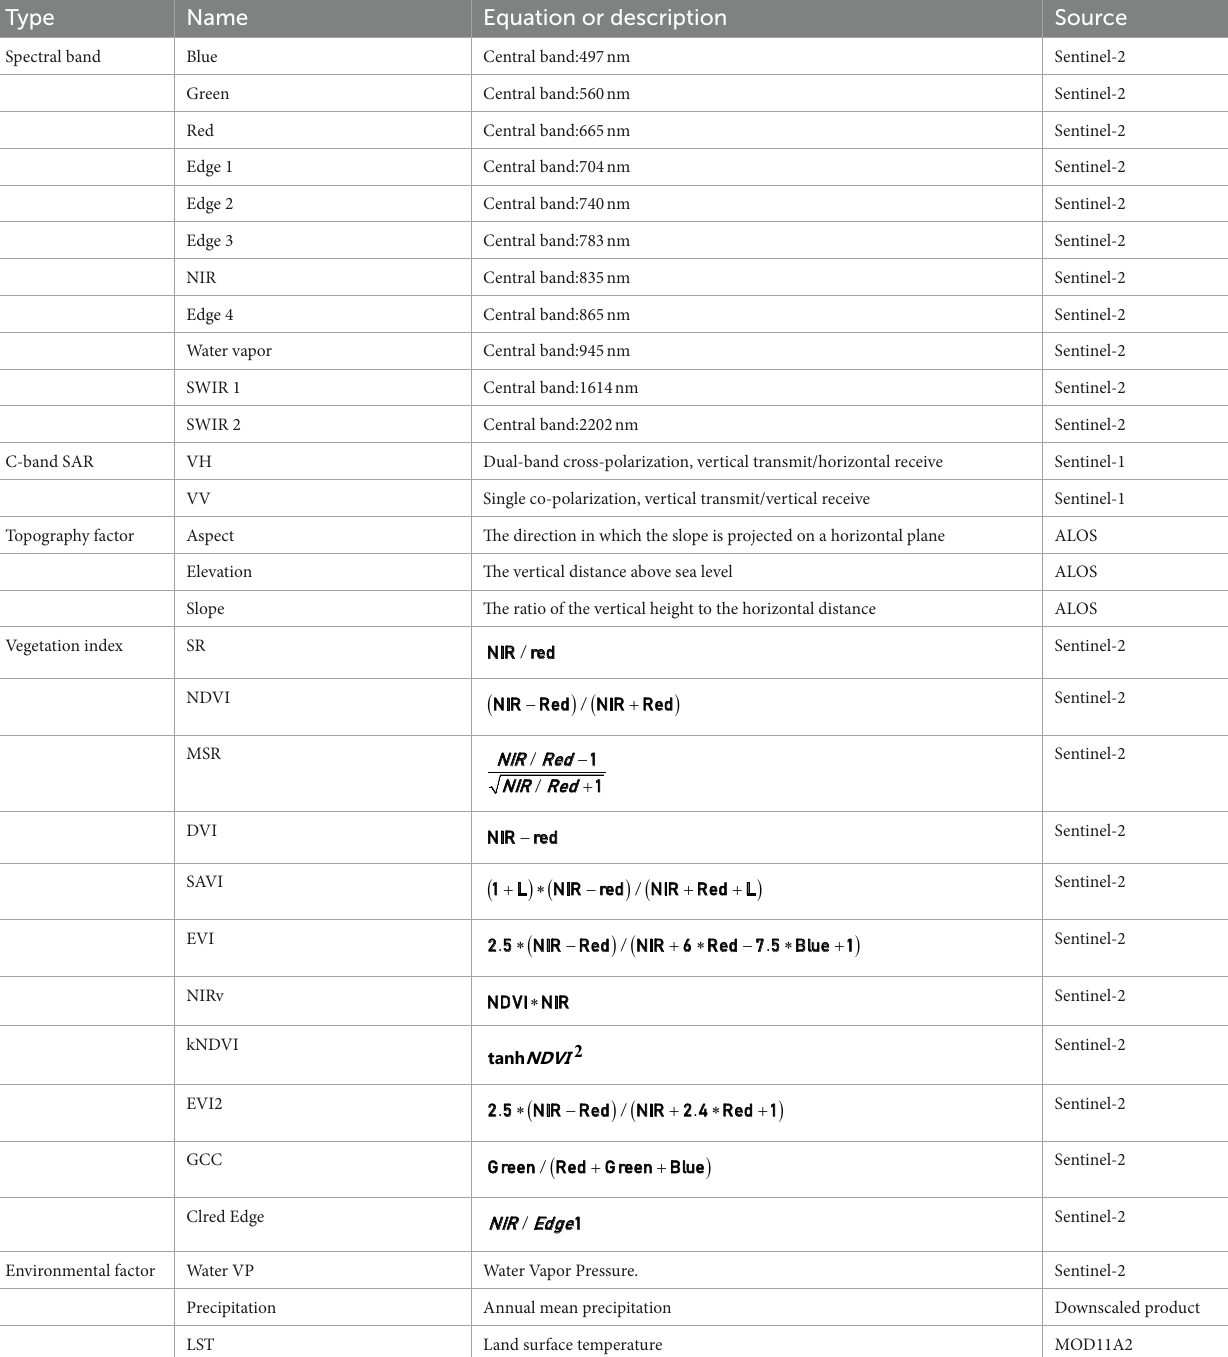
TABLE 1 Features from remote sensing data as inputs of machine learning models for aboveground biomass estimation of grassland and